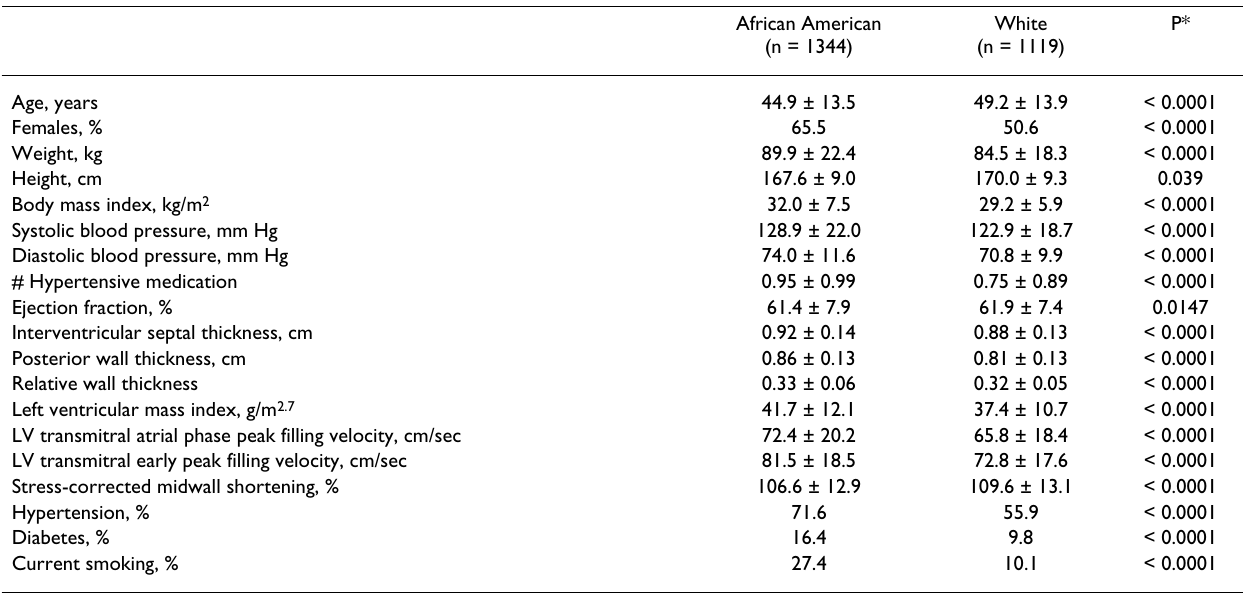
Table 1: Characteristics of Study Sample: Means ± SD or Percentage (%)